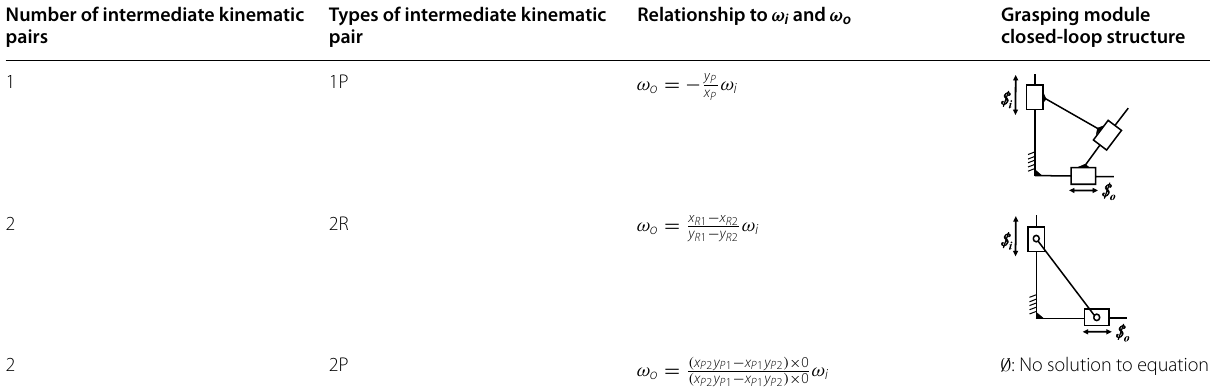
Types of intermediate kinematic